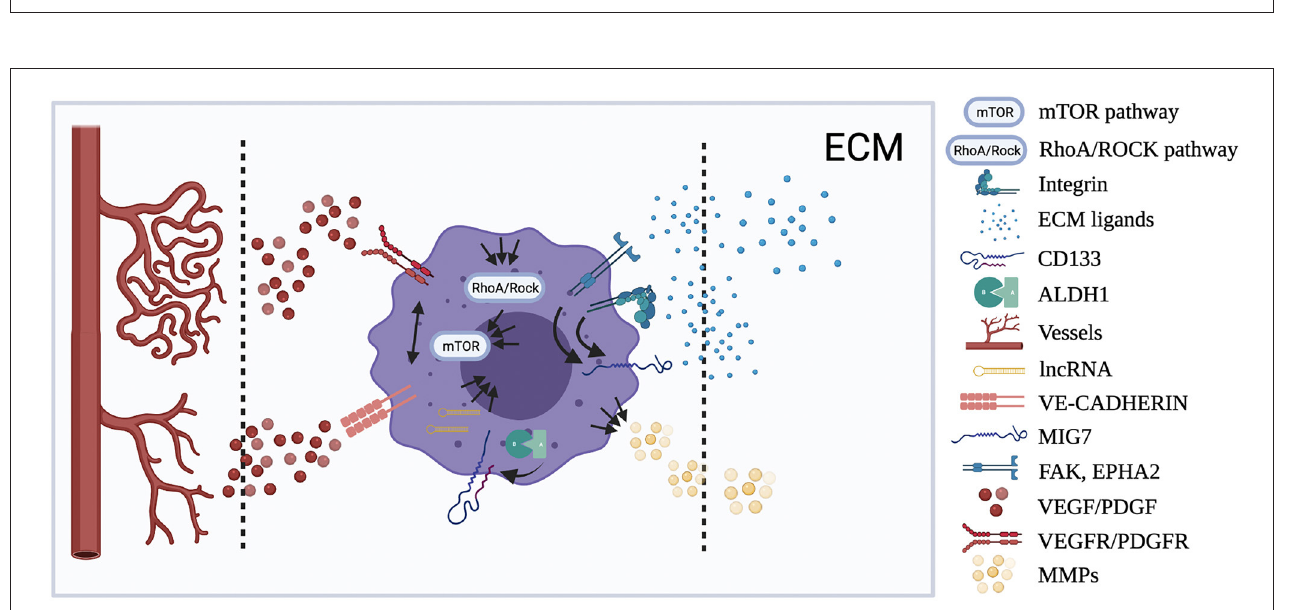
FIGURE 1 | Schematic representation of VM through cancer cells (in purple) forming a vessel containing red blood cells. Figure shows the main molecular pathways involved in the VM process in human osteosarcoma highlighting, in underlined bold, those found to be related with VM presence or tubular/vessel-like formation in vitro in dog.